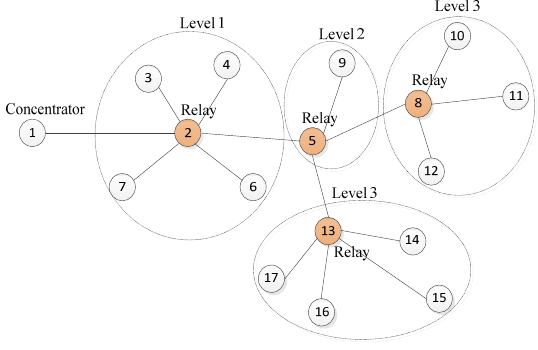
Figure 4. The schematic diagram of static relay selection.